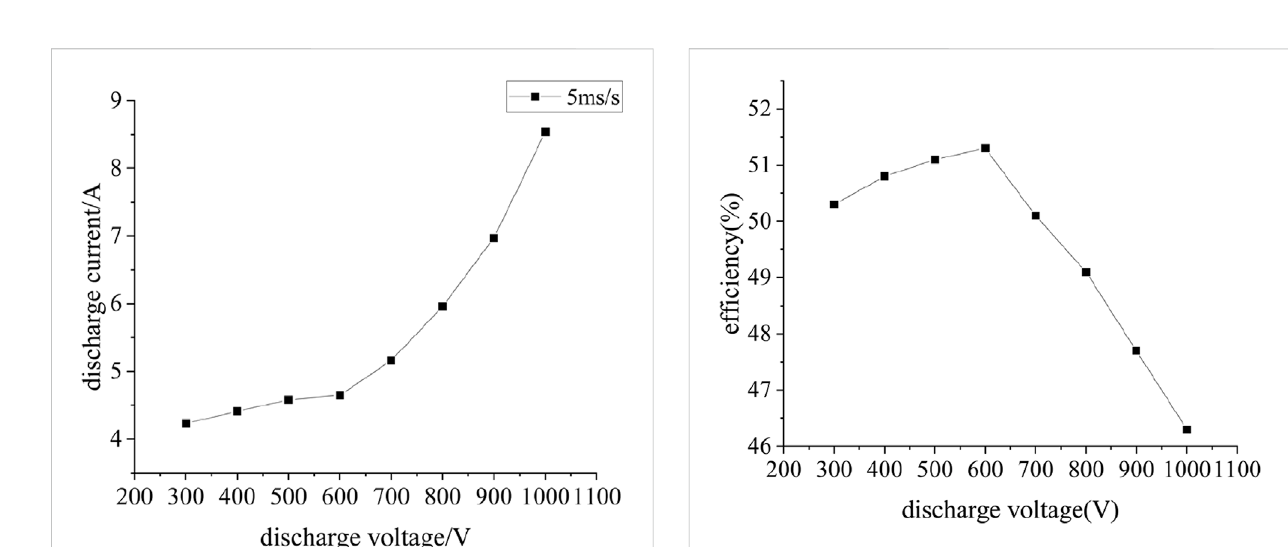
FIGURE 6 Simulated ef fi ciency with changed magnetic fi